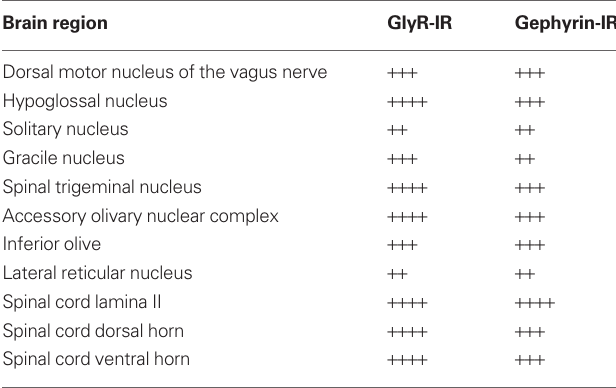
Table 1 | Relative intensity of GlyR-IR and gephyrin-IR in the human medulla oblongata and spinal